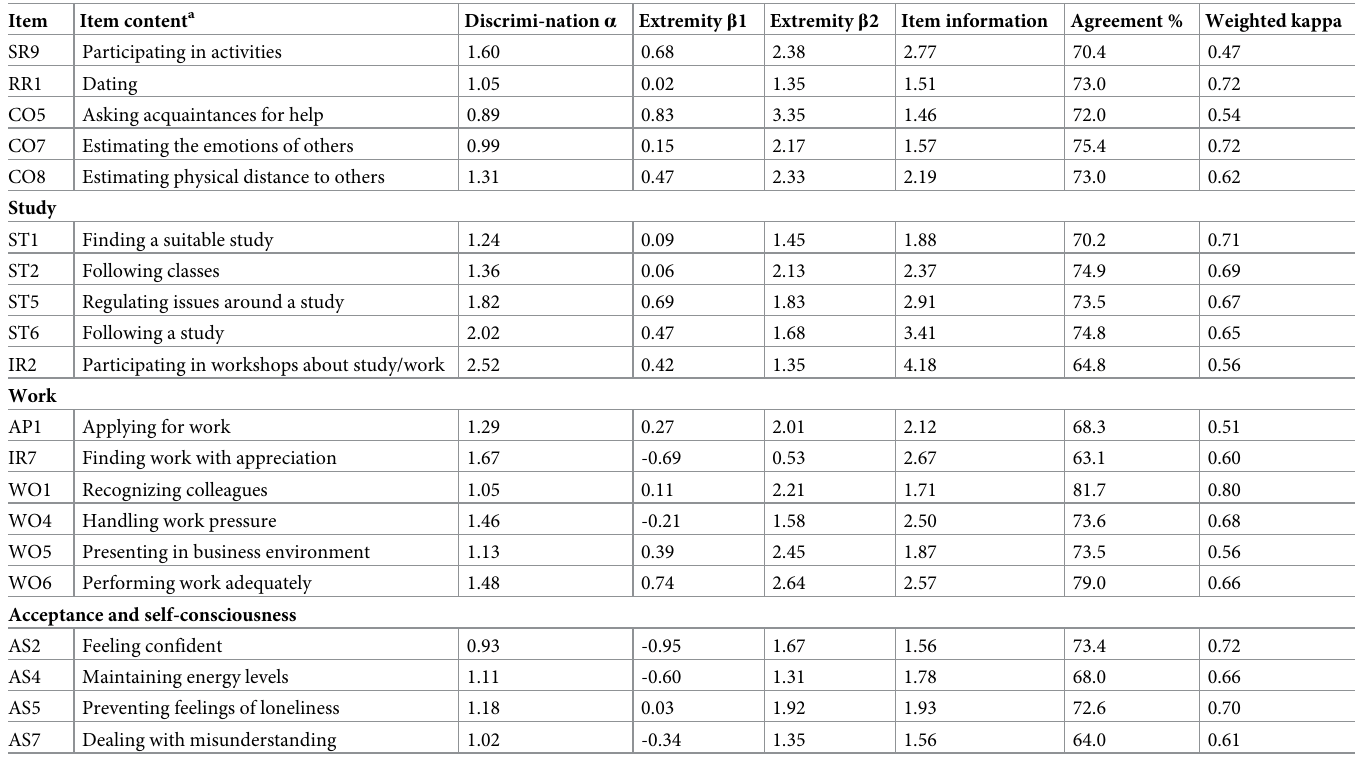
(p = 0.035), who were currently studying (p = 0.001), and who currently had a paid job (p = 0.005). A significant positive correlation was found for theta and age (p = 0.001). To cor- rect for other variables, multiple linear regression showed significant associations between the- tas and degree of visual impairment (p = 0.001), financial situation (p = 0.028) and sex (p = 0.029). Internal consistency for the LVQOL and subscales of the SF-36 and IPA was good, with Cronbach’s alpha of > 0.7 (Table 4). As expected, correlations between the PAI-YA and (scales of) the SF-36, EQ-5D and LVQOL were negative and those between the PAI-YA and scales of the IPA were positive. The PAI-YA was significantly correlated with (all scales of) the SF-36, EQ-5D, IPA and LVQOL (p < 0.01). The strength of the correlations were within the expected range, except for the SR and WO scales of the IPA, which were expected to correlate moderately with the PAI-YA but showed strong correlations instead (Table 4). Test-retest reli- ability of the PAI-YA items was satisfactory for all items (Table 3). In total, 11 items had mod- erate kappa values ( > 0.40), 46 had good values ( > 0.60) and 3 items had very good values ( > 0.80). On inspection, 31 items had moderate agreement (60–74%), 28 had good agreement (75–89%) and 1 item had excellent agreement ( (cid:21) 90%). Evaluation and optimized version of the PAI-YA Over 90% of the young adults were neutral to positive on several aspects of the PAI-YA (Table 5). Mean self-reported administration time of the PAI YA (including questions on demographic and clinical characteristics) was 45.52 ± 27.90 (range 8–180, median 40)